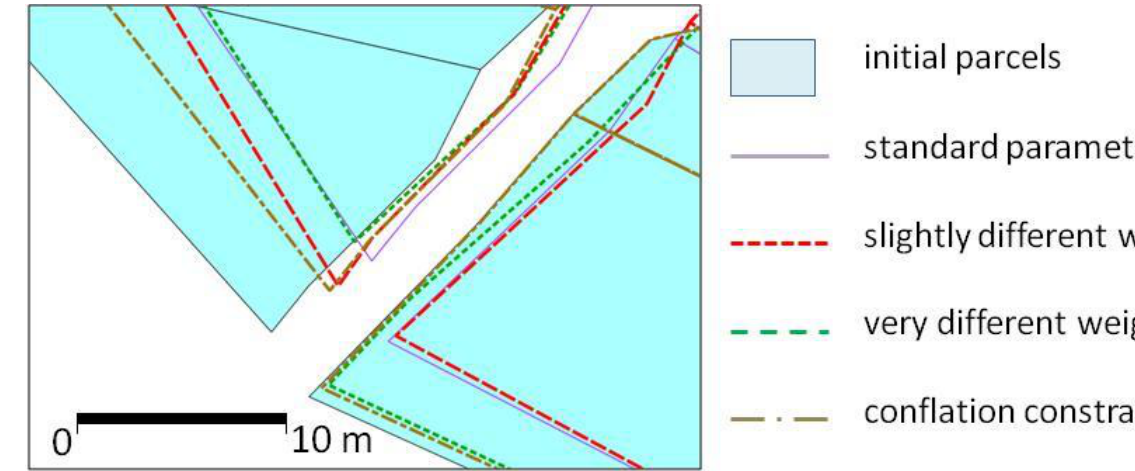
Figure 24. Conflation variations with varying